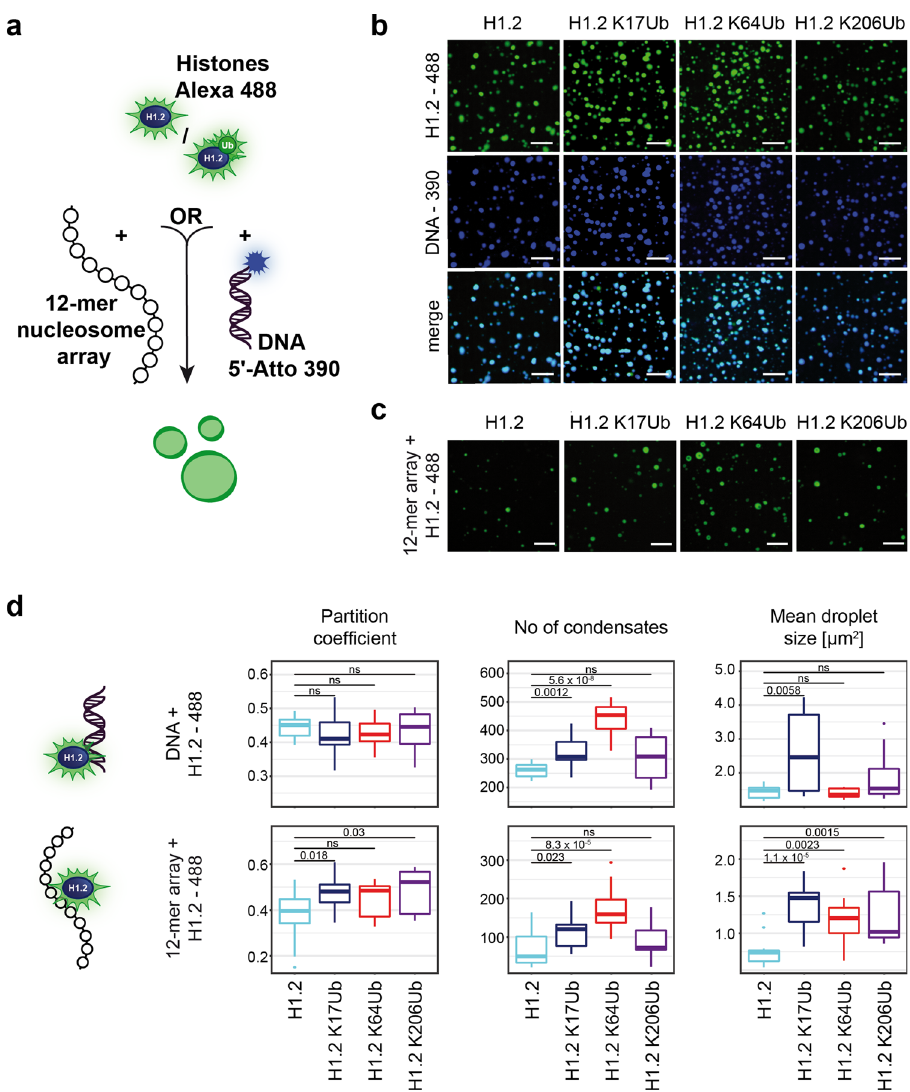
Fig. 5 H1.2 KxUb-dependent condensate formation. a Overview of condensate formation assay using fl uorescently labeled H1.2 and H1.2 KxUbs where either the nucleosome positioning DNA or intact 12-mer nucleosome arrays were added. The different linker histone variants were chemically labeled with Alexa Fluor 488-NHS, DNA was ampli fi ed with a 5 ’ -Atto-390-modi fi ed primer while the DNA array was not labeled. b Representative microscopic images of various H1.2- and H1.2 KxUb-DNA condensates. Shown are images after excitation with a 488 nm laser (green) or a 405 nm laser (blue) and the merged images (light blue). Scale bar 10 µ m. c Representative microscopic images of H1.2- and H1.2 KxUb-array condensates. Shown are images after excitation with the 488 nm laser (green). Scale bar 10 µ m. d Characterization of H1.2- and H1.2 KxUb-DNA (top) and H1.2- and H1.2 KxUb-nucleosome array (bottom) condensates. Shown are the partition coef fi cient (left), the number of droplets (middle), and mean droplet size (right) 20 min after mixing. Data were extracted from the images in the histone (green) channel and are shown as boxplots where the midline represents the medians, the upper and lower bounds the interquartile ranges, and the whiskers extend to 1.5 times the interquartile range (two-sample t -test; n = 4, exact p values with p ≤ 0.05 are shown, ns (not signi fi cant) p >